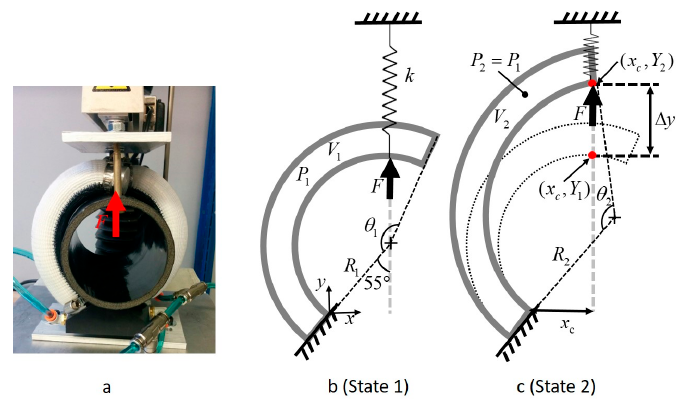
Figure 8. Payload model. ( a ) Location of the payload force application point in the physical gripper; ( b ) State 1 and ( c ) State 2 of the actuator’s payload model.